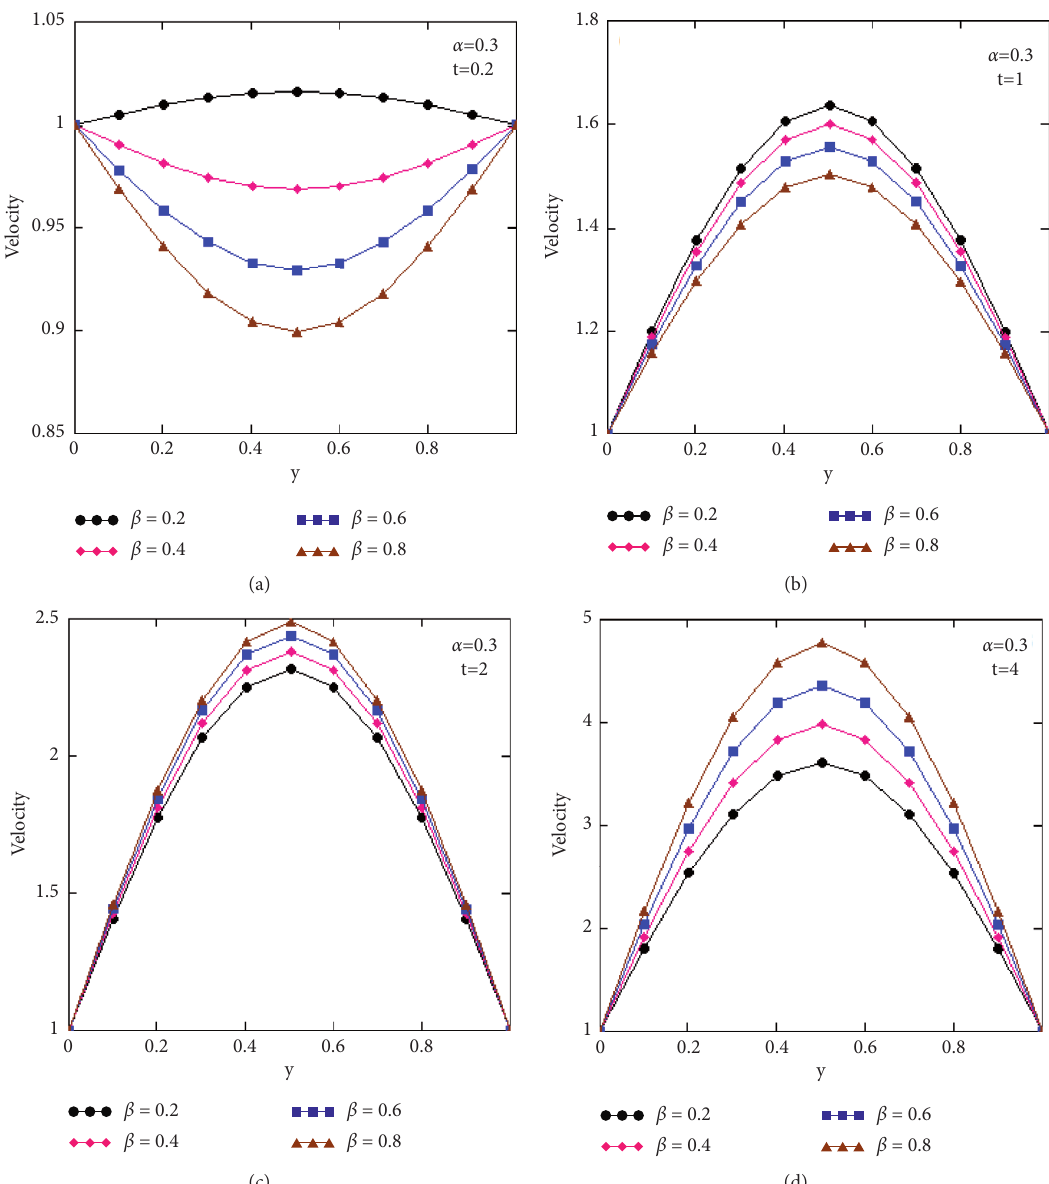
Figure 9: Profiles of dimensionless velocity versus y for variation of β at altered values of time t , Gr � 5 , λ � 2 , λ ( t ) � f ( t ) � H ( t ) � g f 1 1